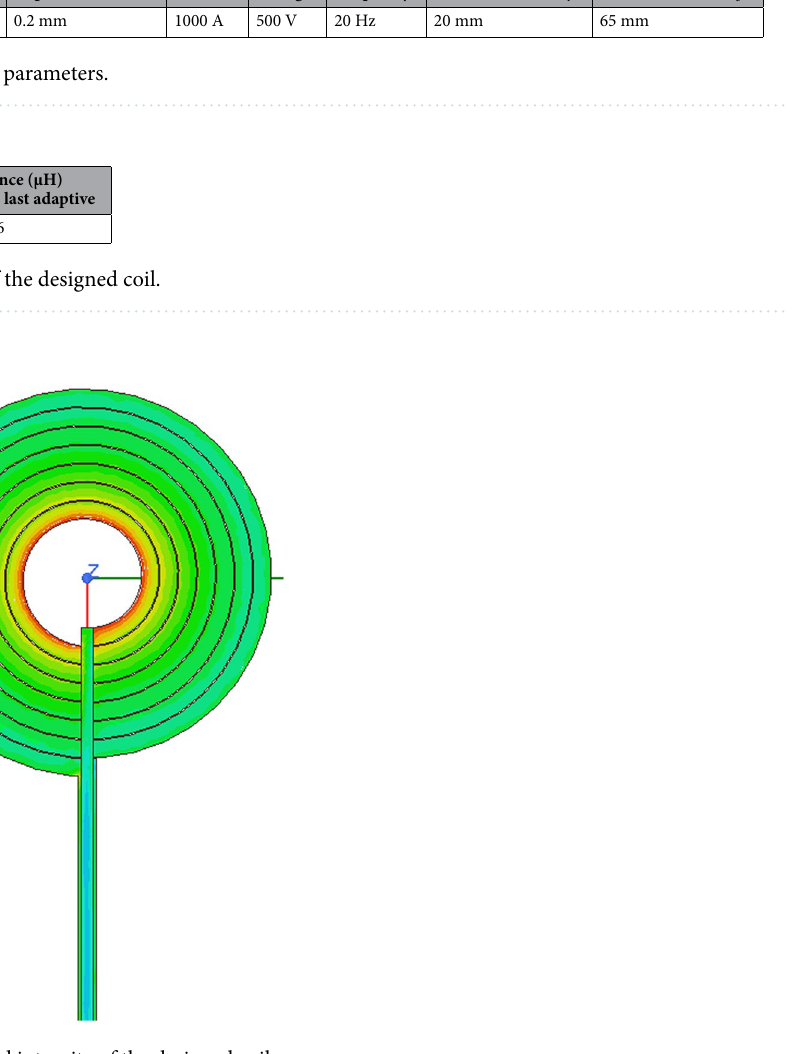
Figure 3. Magnetic field intensity of the designed